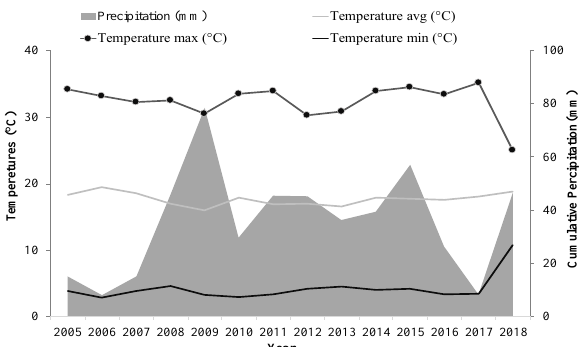
Figure 2. Average temperature (maximum, mean and minimum) and cumulative precipitation from June to September in Ardabil for the period 2005 to 2018.